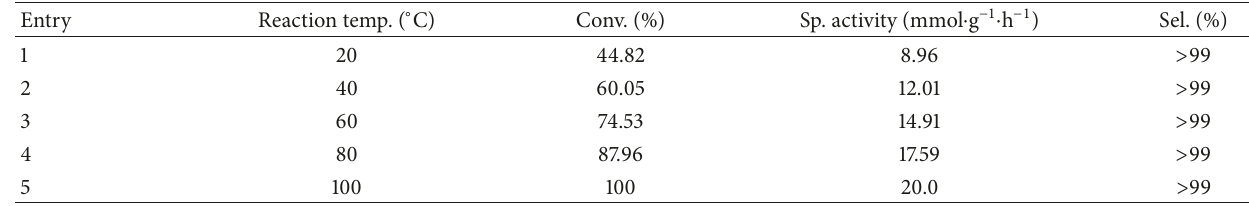
Table 3: Effect of reaction temperature on the catalytic performance. [ a ]